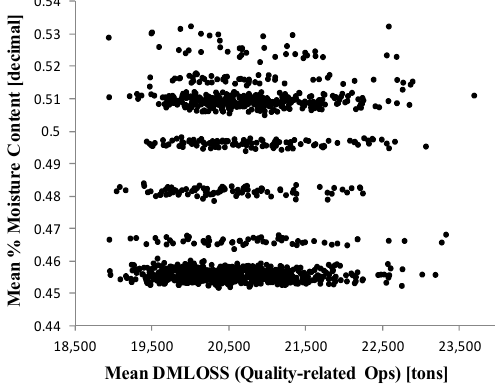
Figure 6. Average MC vs. DMLOSS (schedule (*)).